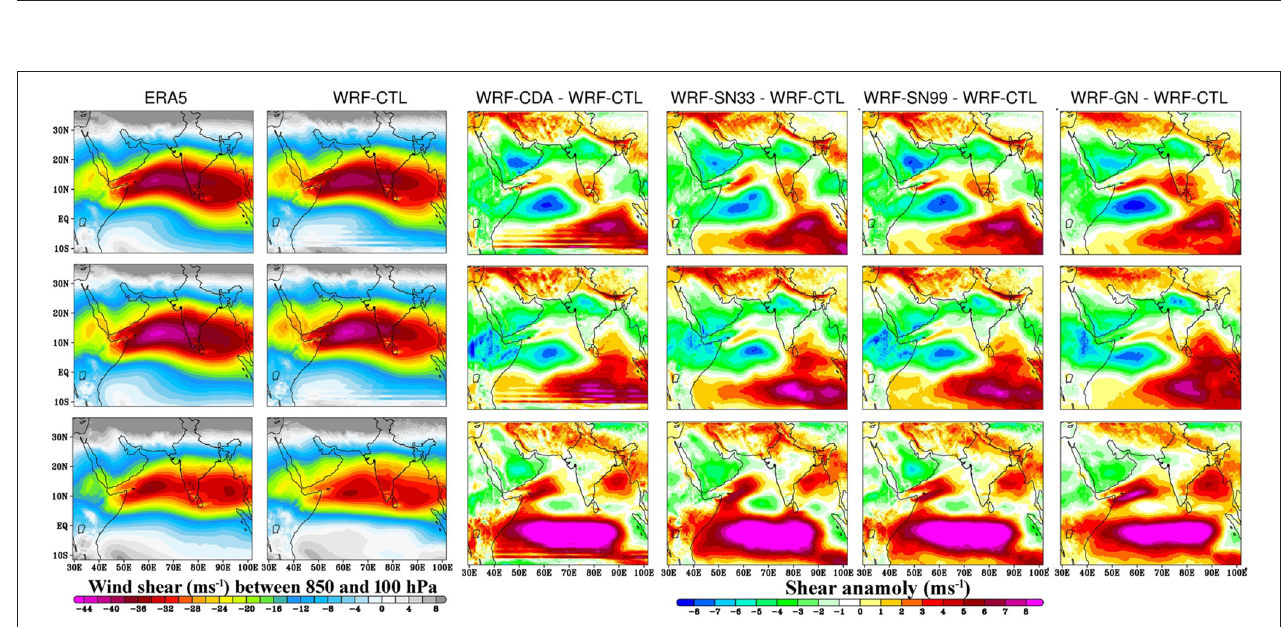
FIGURE 7 | The mean seasonal zonal wind shear (m/s) between 850 hPa and 100 hPa levels of ERA5 (First column) and WRF-CTL (Second column), and the differences in the mean zonal wind shear (m/s) between the WRF-CDA and WRF-CTL (Third column), WRF-SN33 and WRF-CTL (Fourth column), WRF-S99 and WRF-CTL (Fifth column), and WRF-GN and WRF-CTL (Sixth column) during normal (2016), excess (2013), and drought (2009) Indian Summer Monsoon seasons. First row is for normal, second row is for excess, and third row is for drought Indian Summer Monsoon seasons.